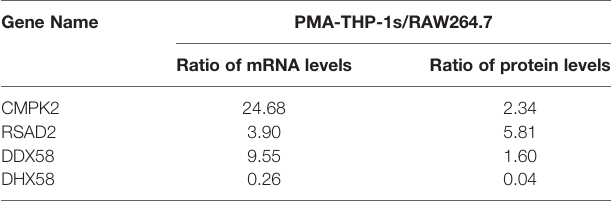
TABLE 2 | Comparison of transcriptional and translational levels of CMPK2, RSAD2, DDX58 and DHX58 in M0 macrophages between the two cell